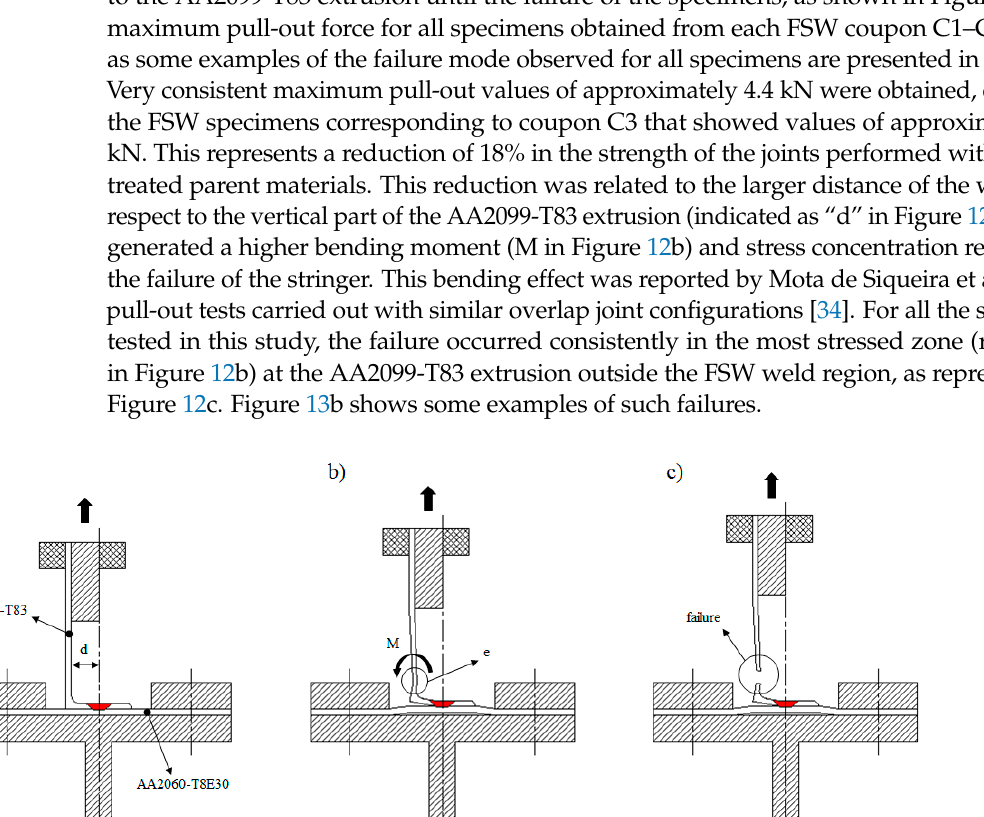
Figure 11. ( a ) Cross-sectional macrograph and detail magnification of the FSW weld from coupon C6 and ( b ) SEM image and EDS analysis of the region indicated as detail A in Figure 11a.